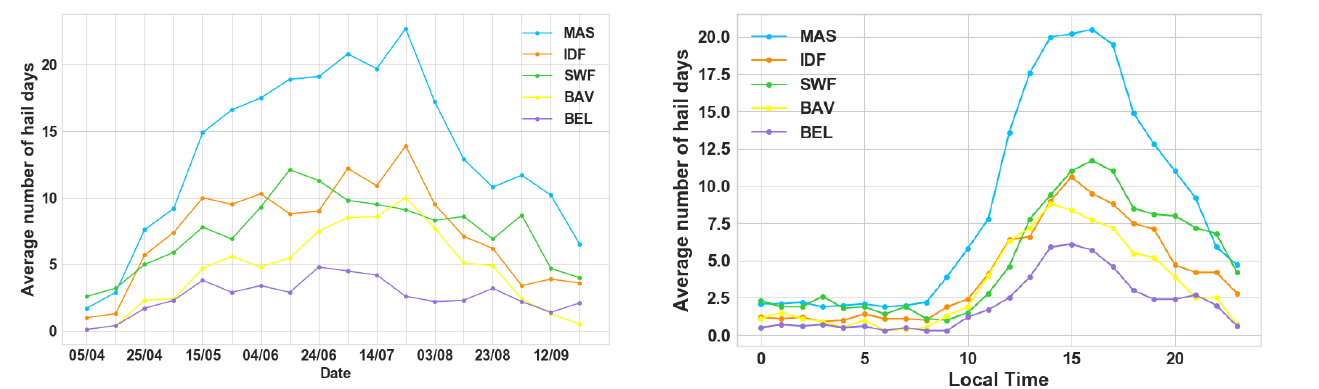
Figure 8. Hourly distribution of the mean number of radar-derived hail days for each